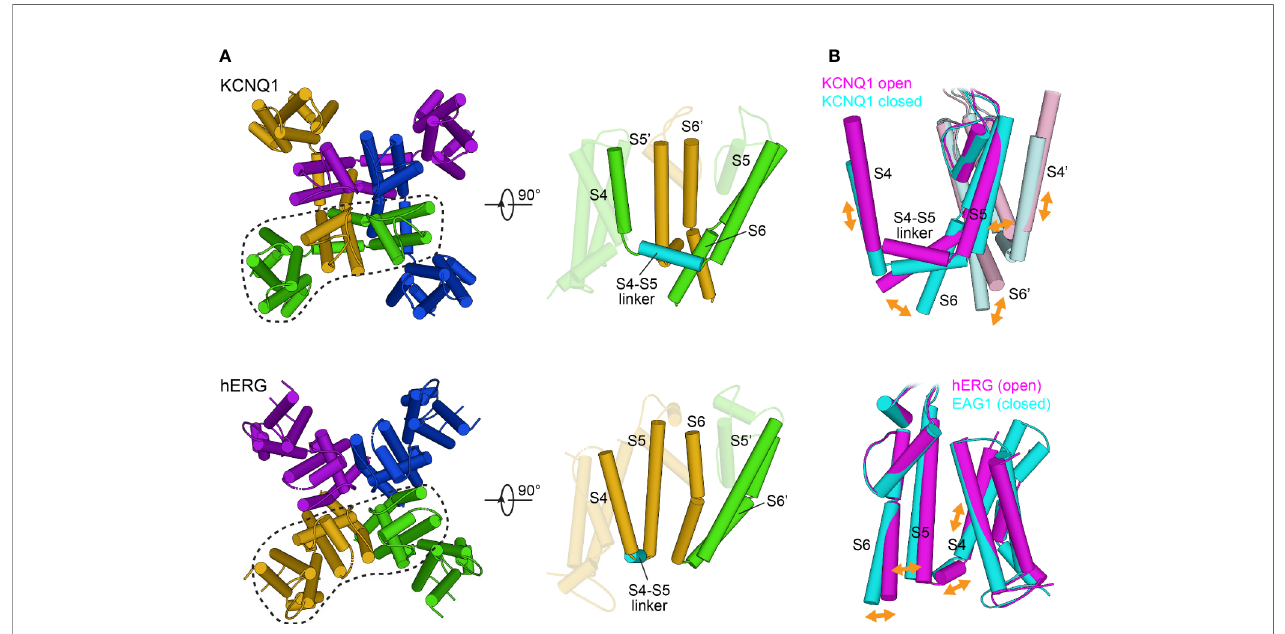
FIGURE 5 | Structural features of electromechanical coupling in the KCNQ1 and hERG channels. (A) Left: Extracellular view of KCNQ1 and hERG transmembrane segments S0 to S6. Individual subunits are drawn with different colors. KCNQ1 (PDB: 6UZZ) (Sun and Mackinnon, 2020) has a domain-swapped architecture whereas hERG (PDB: 5VA1) (Wang and Mackinnon, 2017) channels are non-domain-swapped. Right: Cartoon representation of a single subunit and its neighboring pore segments (S5 to S6). In KCNQ1, the VSD and PD are bridged by an extended a -helical S4 – S5 linker, whereas in hERG, S4 and S5 are connected by only a short helix. (B) Implications for the direction of coupled motions between the VSD and PD based on molecular modeling of KCNQ1 in open and closed conformations (top) and comparison of the open state structure of hERG with the closed state structure of EAG1 (PDB: 5K7L) (Whicher and Mackinnon, 2016) (bottom). In the domain-swapped KCNQ1 channel, the S4 movement is transmitted to the gate through the S4 – S5 linker. In hERG and EAG1, the S4 movement is proposed to exert a direct force on the S5 – S6 interface to compress or open the channel